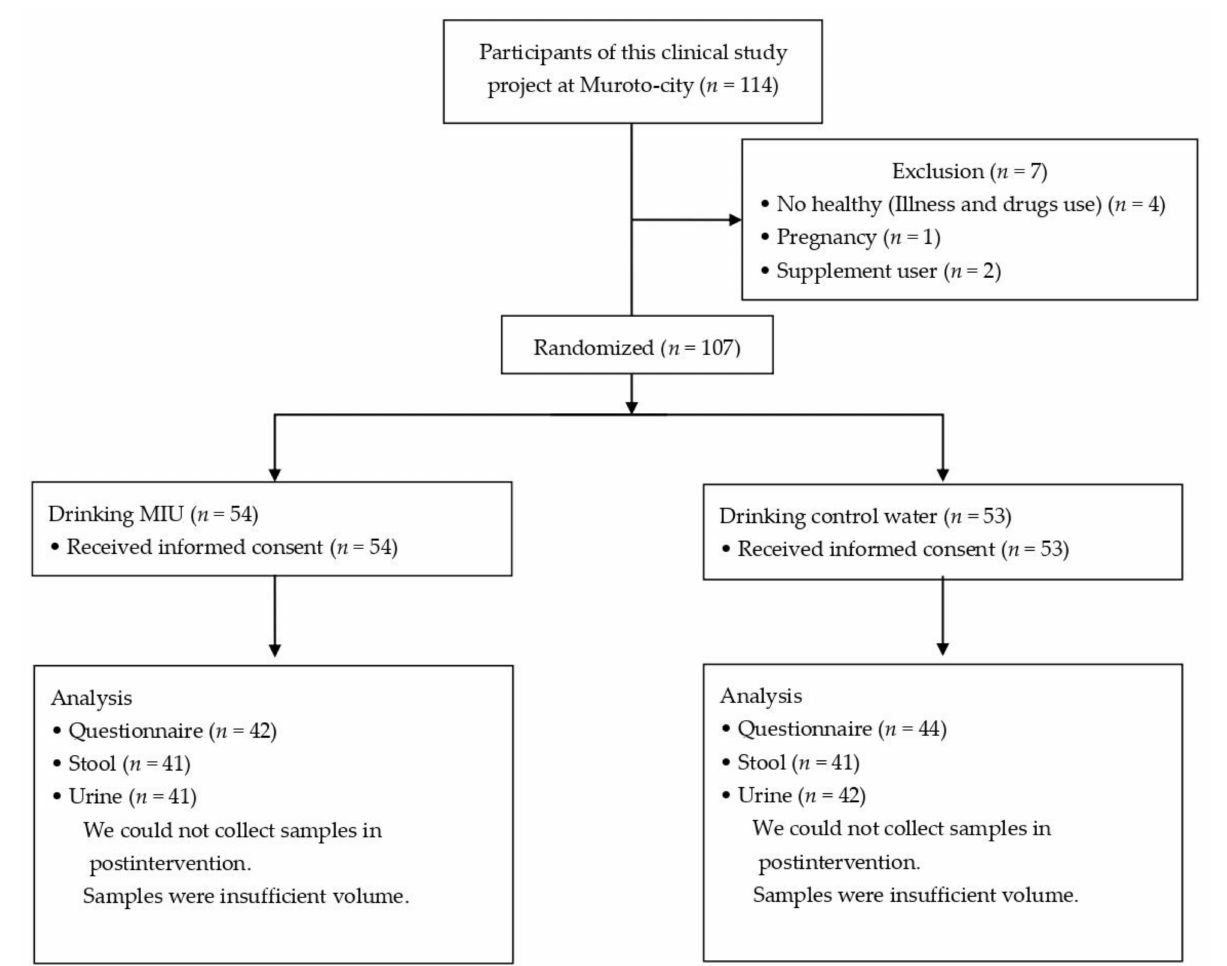
Figure 1. Flow diagram of this clinical study. A total 107 healthy adults were enrolled from Muroto, Kochi, Japan. Potential participants with any current illness, those using any prescription or com- mercial drugs or dietary supplements, and pregnant women were excluded. Participants in the experimental group consumed MIU (hardness, 88) and those in the control group consumed mineral water (hardness,